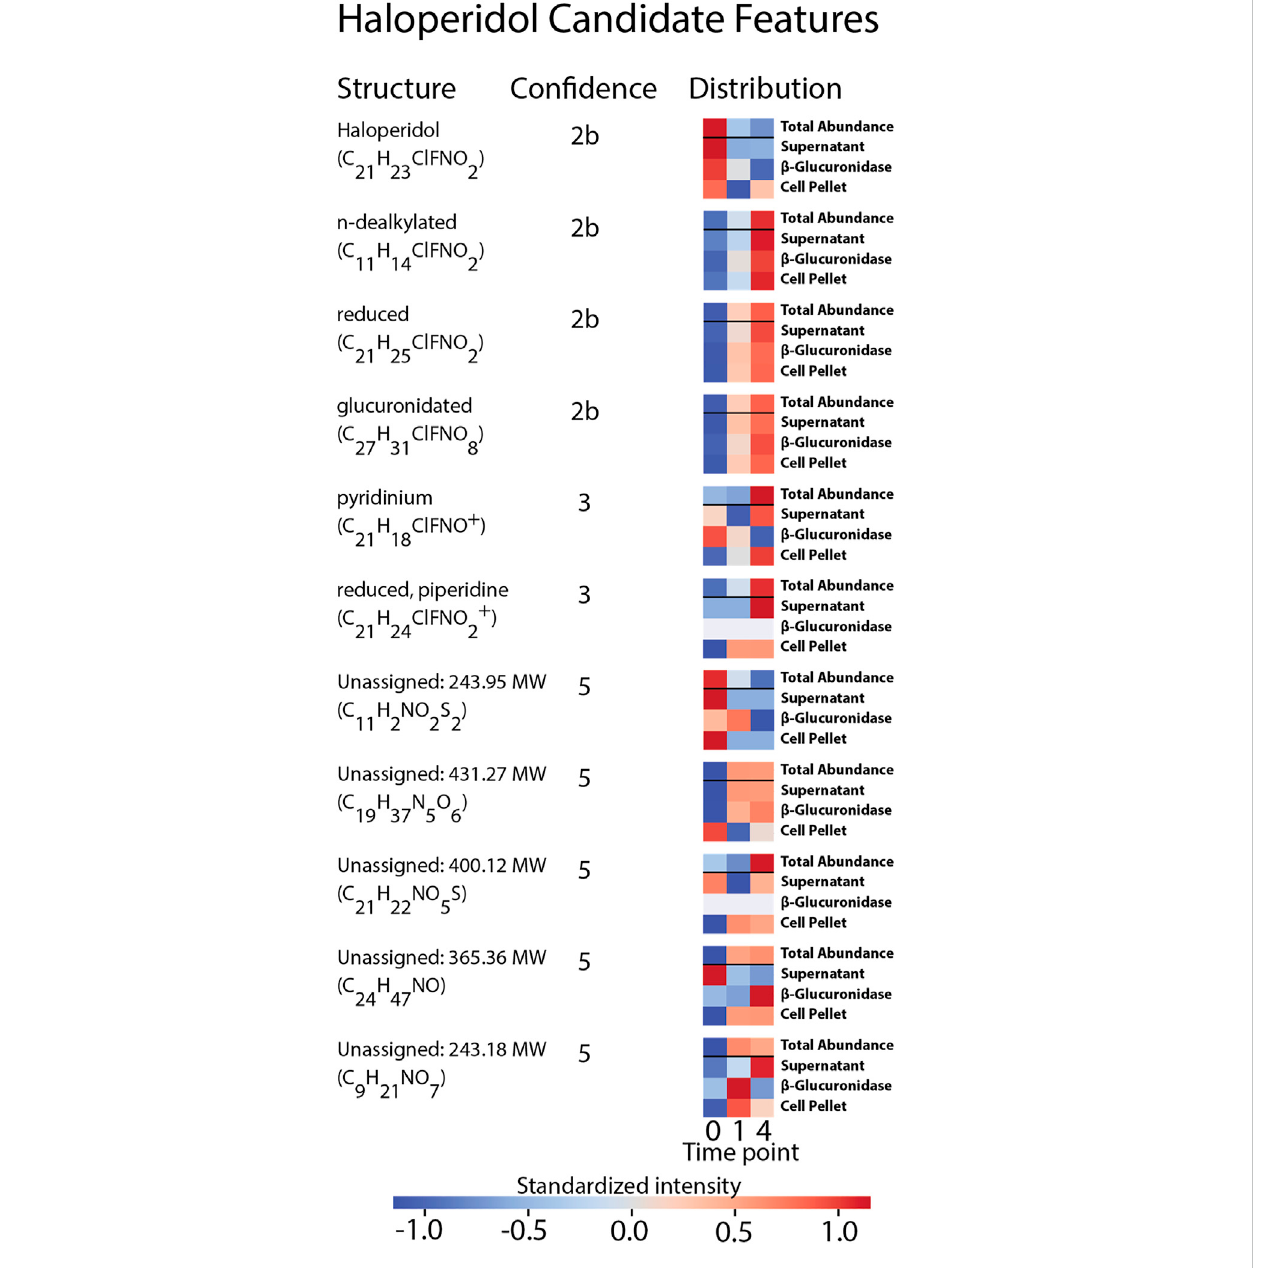
FIGURE 5 Summary of thestructural assignmentsfor each candidate feature selected from theanalysis ofhaloperidol.Con fi dence inmetabolite identi fi cation was assigned using three levels of con fi dence derived from Schymanski et al. (2014).